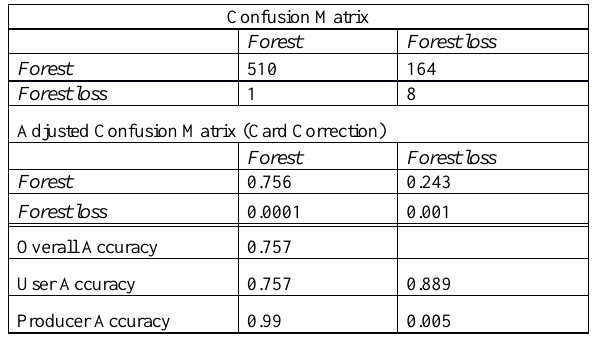
Table 2. accuracy assessment results described in error